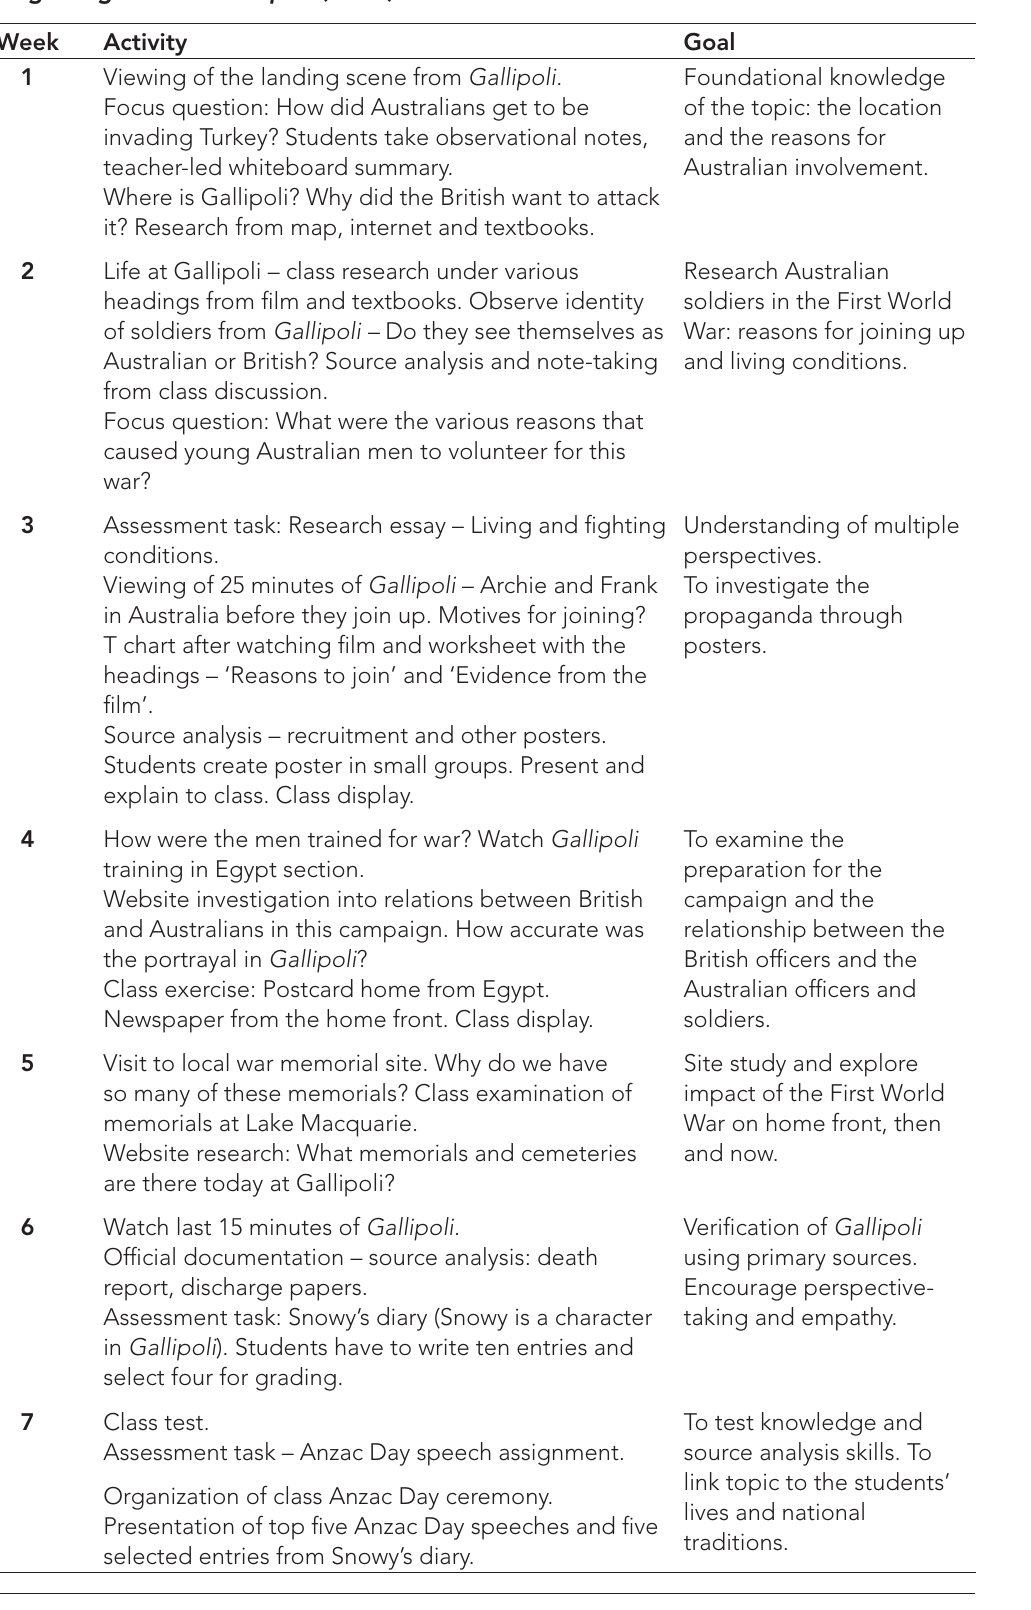
Table 1: Mrs Warner’s Stage 5 Year 9 (14–15 year olds) Core Study – Depth Study 3: Australians at war: World Wars I and II ( NSW History K-10 Syllabus , 76–7), integrating the film Gallipoli